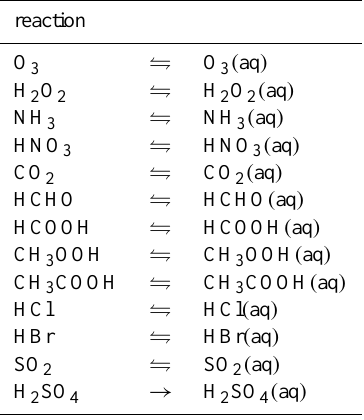
Table 2. Gas-to-liquid transfer reactions considered.